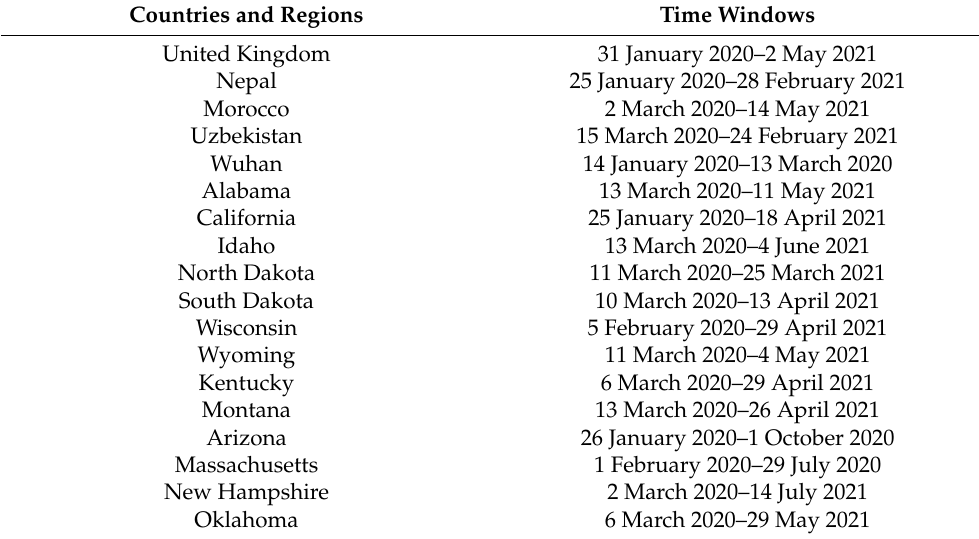
Table 1. Time windows for the different countries and regions studied.